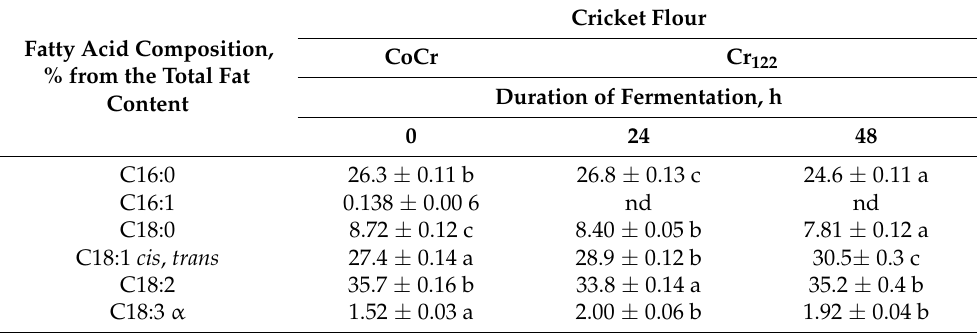
Table 4. Fatty acid (FA) composition (% from the total fat content) in non-treated and fermented cricket